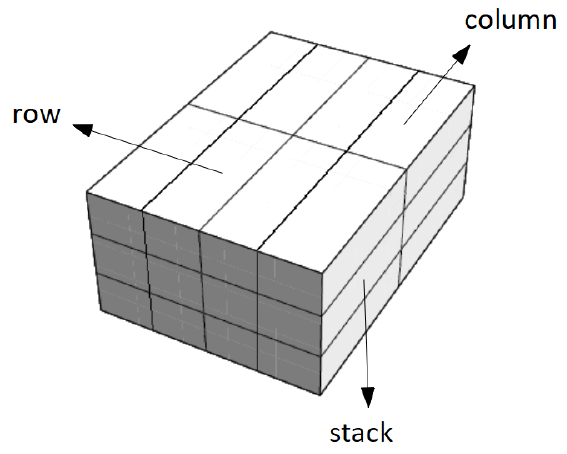
Figure 2. A simple block with four boxes in a row, two boxes in a column, and three boxes in a stack.